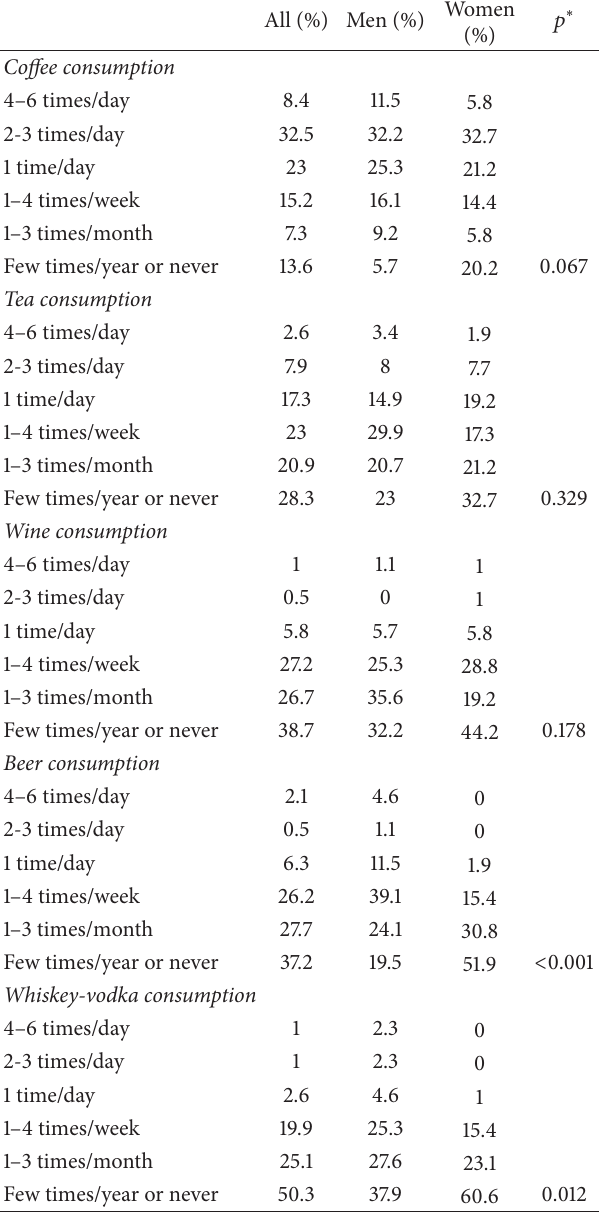
Table 4: Coffee, tea, and alcohol consumption in all and men and women